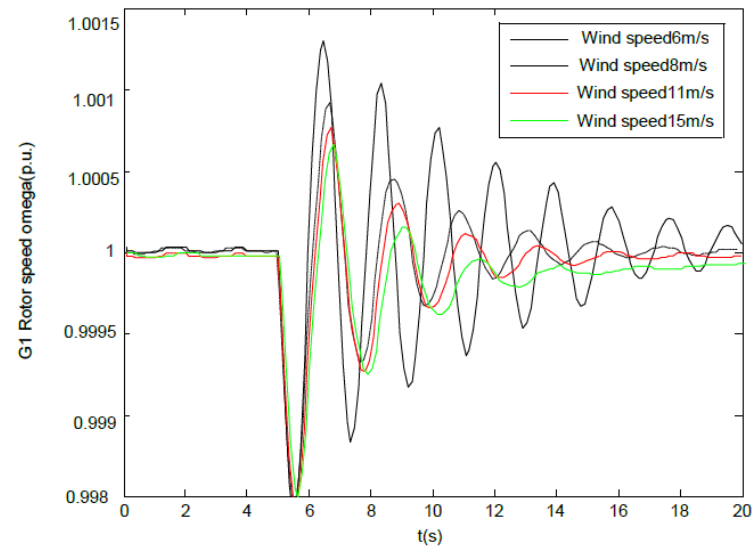
Figure 9. Rotor speed of G1 under different wind speed adopting existing damping control. Table 4. Dynamic performance under different wind speeds adopting existing damping control .